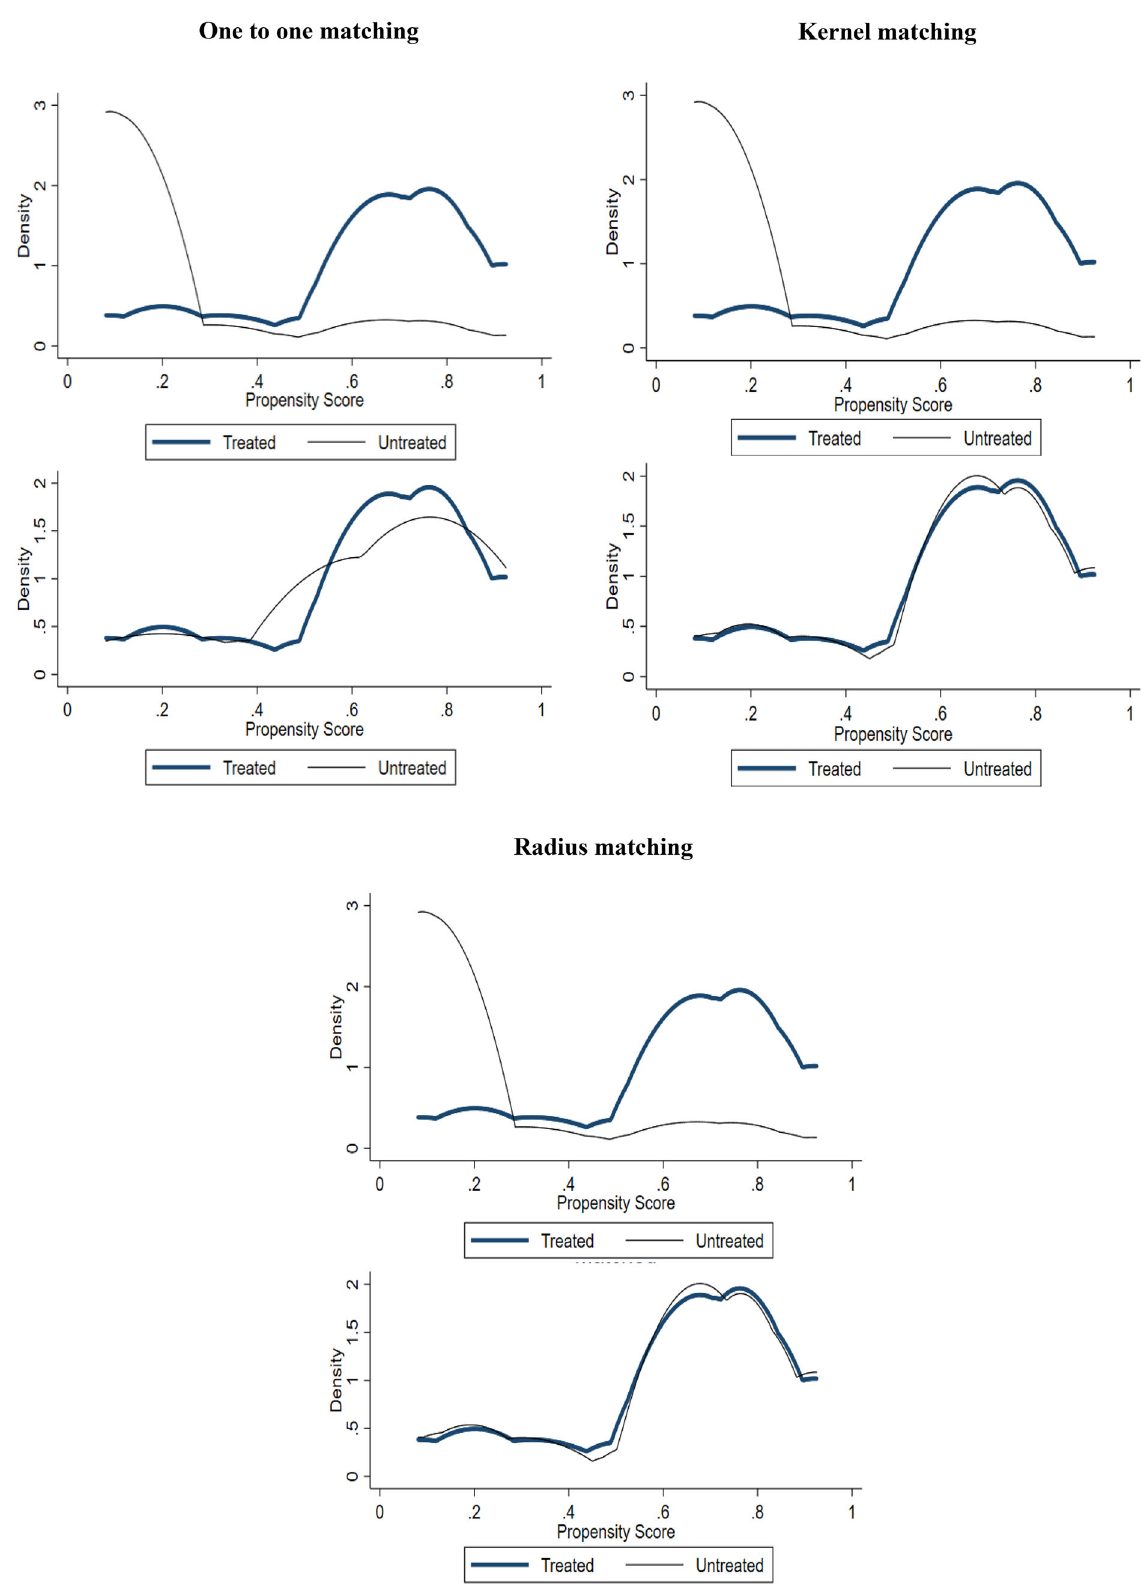
Fig. 7 Kernel distribution of propensity scores from the probit model controlling for physical conditions of households, before and after matching, in Picsi, Chiclayo Province,